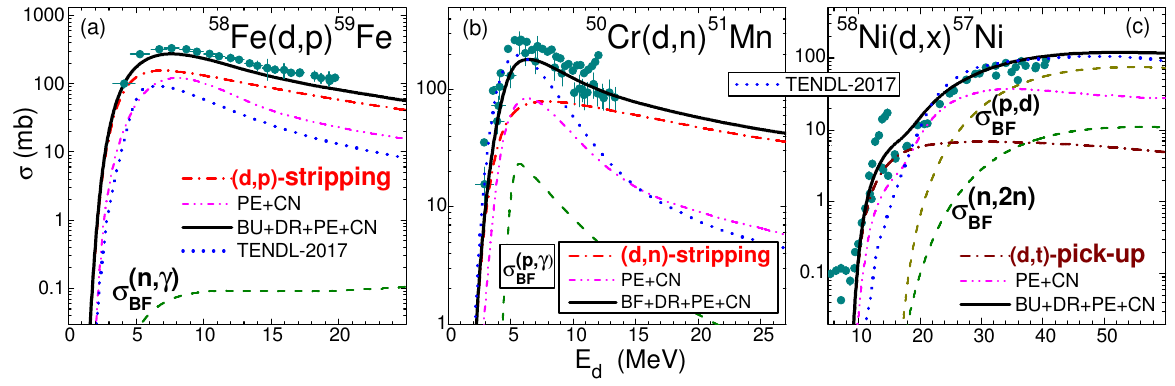
Figure 4. Same as Fig. 2 but including the DR (dot-dashed curves) contributions, important for the first chance emitted particle